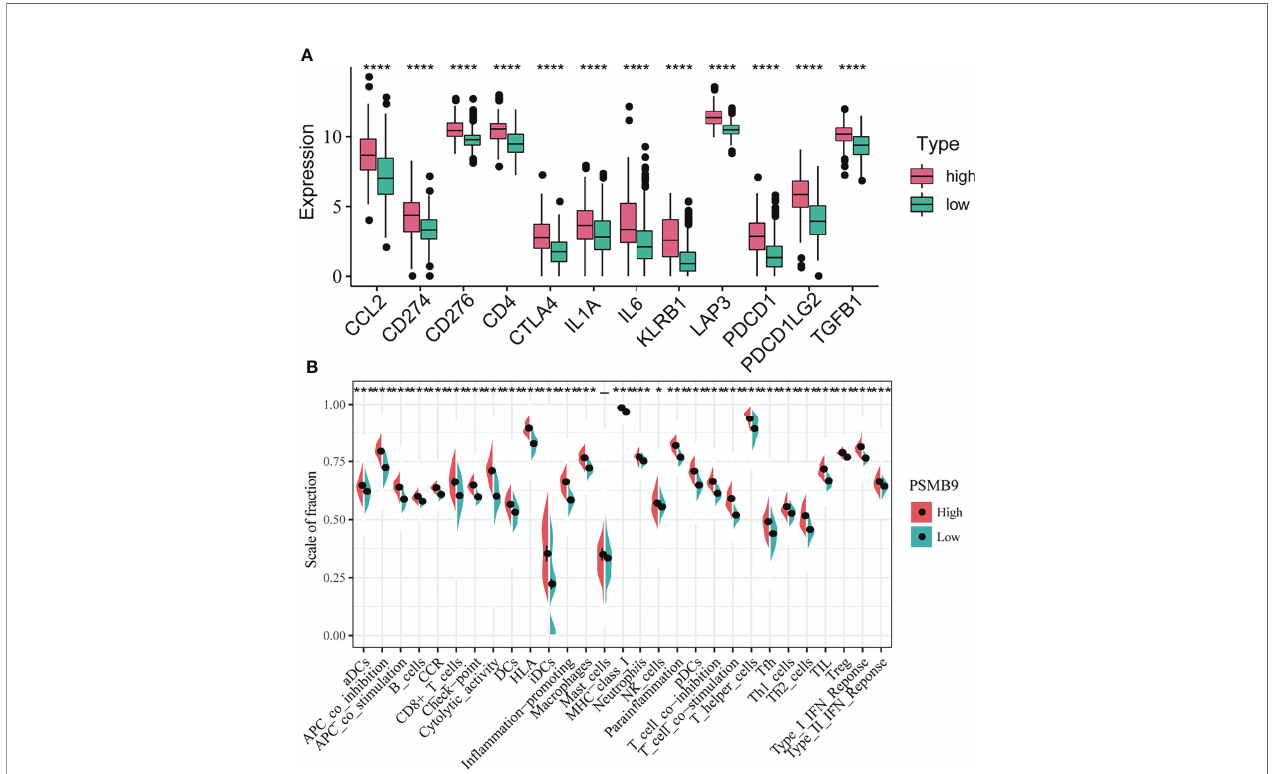
FIGURE 6 | Differential analysis of immune characteristics between high and low PSMB9 expression groups. (A) In the high-PSMB9 expression group, the expression of 12 common immune checkpoints is up-regulated, and there was signi fi cant statistical signi fi cance in the high and low expression groups of PSMB9. (B) In the high-PSMB9 expression group, the in fi ltration scale of immune cells and abundance of immune-related molecules based on the results of ssGSEA were signi fi cantly up-regulated. (ns P>0.05; *P<0.05; **P<0.01; ***P<0.001;